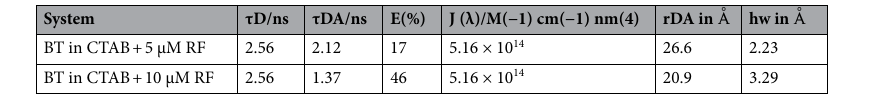
Table 2. FRET parameters of BT (donor) and RF (acceptor) in CTAB